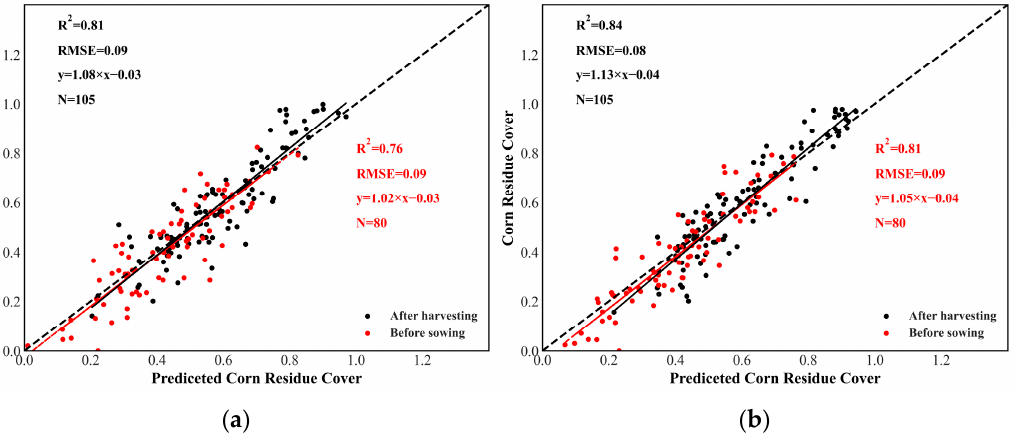
Figure 10. Estimated result of CRC by multiple linear regression ( a ) and random forest ( b ) after soil texture zoning.